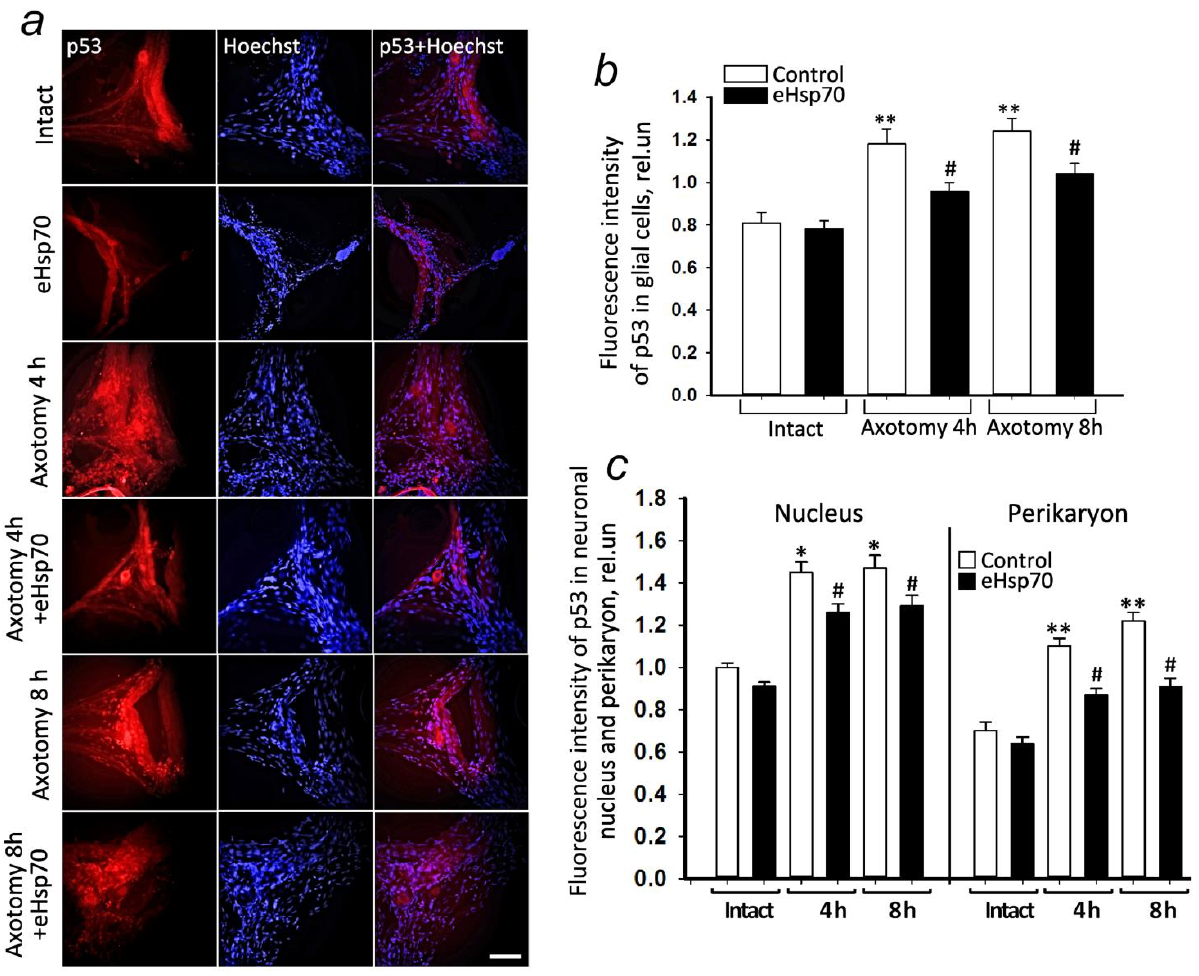
Figure 4. Immunofluorescence analysis of p53 levels in the glial cells, nuclei, and perikaryon of the mechanoreceptor neuron of the crayfish stretch receptor. ( a ) The representative immunofluorescence images of p53 localization (red) and Hoechst (blue, nuclear-specific marker) in the MRN in normal conditions and at 4–8 h after axotomy in the presence and absence of eHsp70 (600 nM). ( b ) Changes in the level of p53 fluorescence in glial cells after axotomy (4–8 h) in the presence and absence of eHsp70. ( c ) Changes in the level of p53 fluorescence in the nuclei and the perikaryon of neurons. Scale bar, 100 µm. N = 10. * p < 0.05; ** p < 0.01 compared to the intact group. # p < 0.05 compared to the axotomy group (4 h and 8 h). A decrease in p53 levels can be seen in the glial cells and both in the nuclei and in the perikaryon of the neurons under the effect of